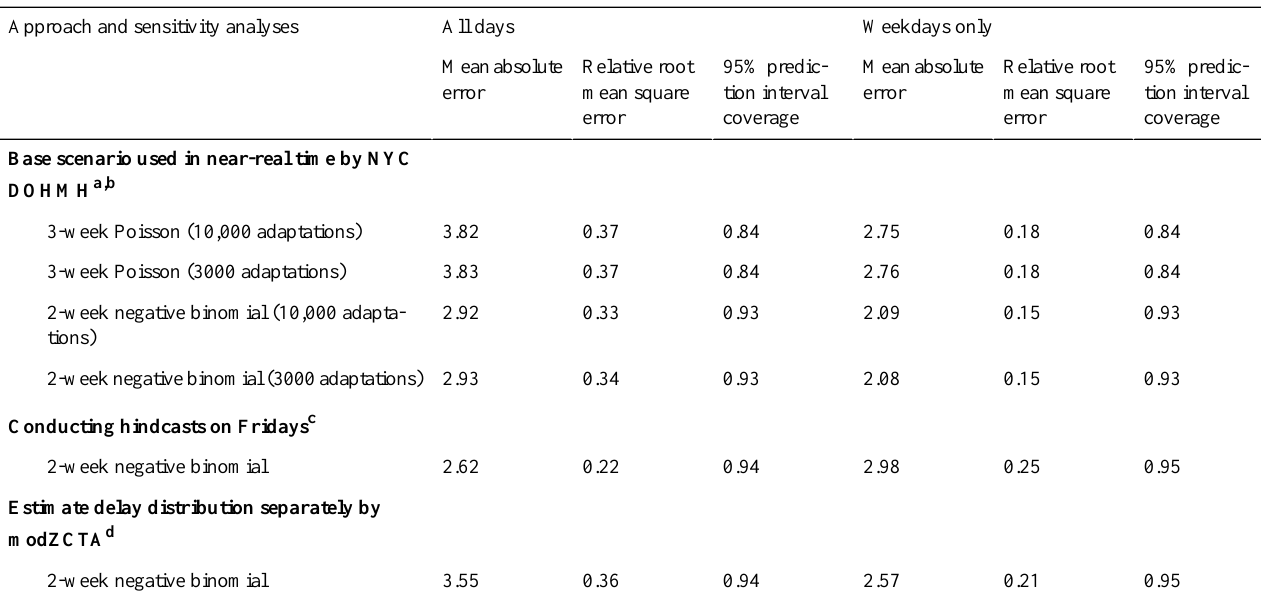
Table 2. Performance measures for hindcasting approaches in Nowcasting by Bayesian Smoothing (NobBS), applied to case counts of New York City residents diagnosed with COVID-19 from March 22 to May 31, 2020, stratified by modified ZIP Code Tabulation Area (modZCTA) of